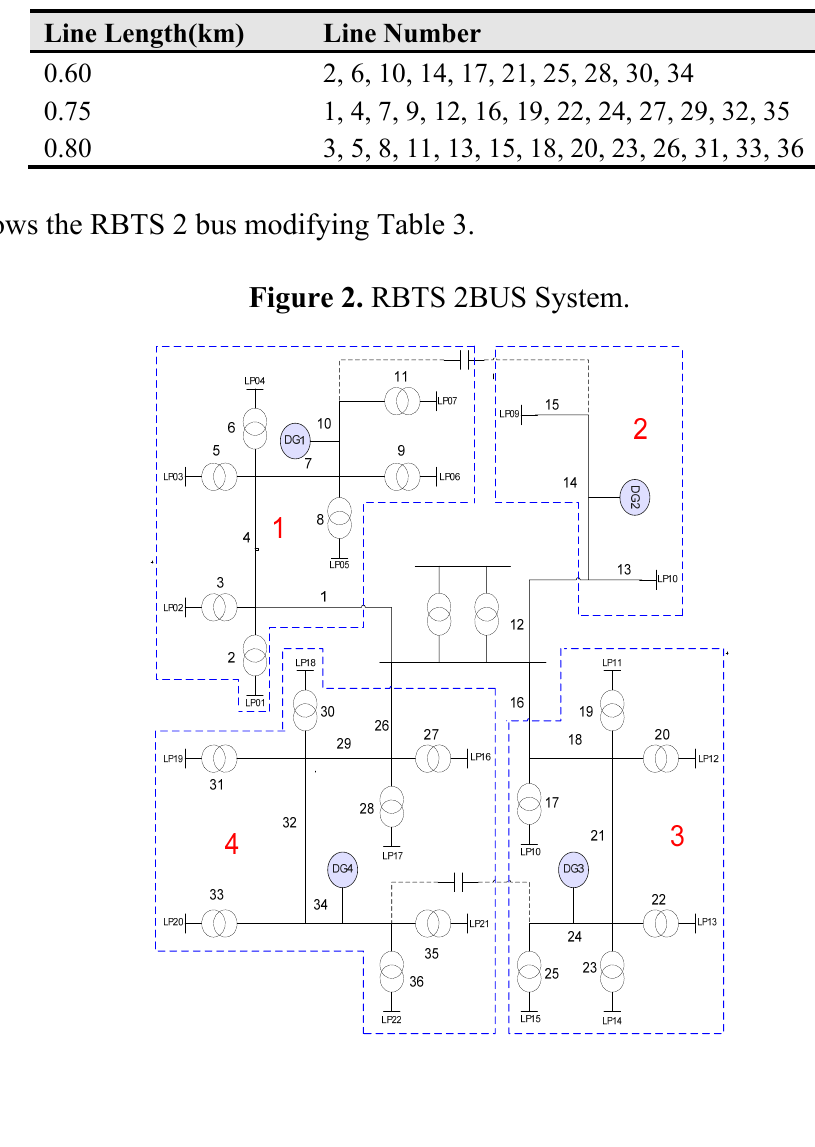
Table 3. Loss data [14].